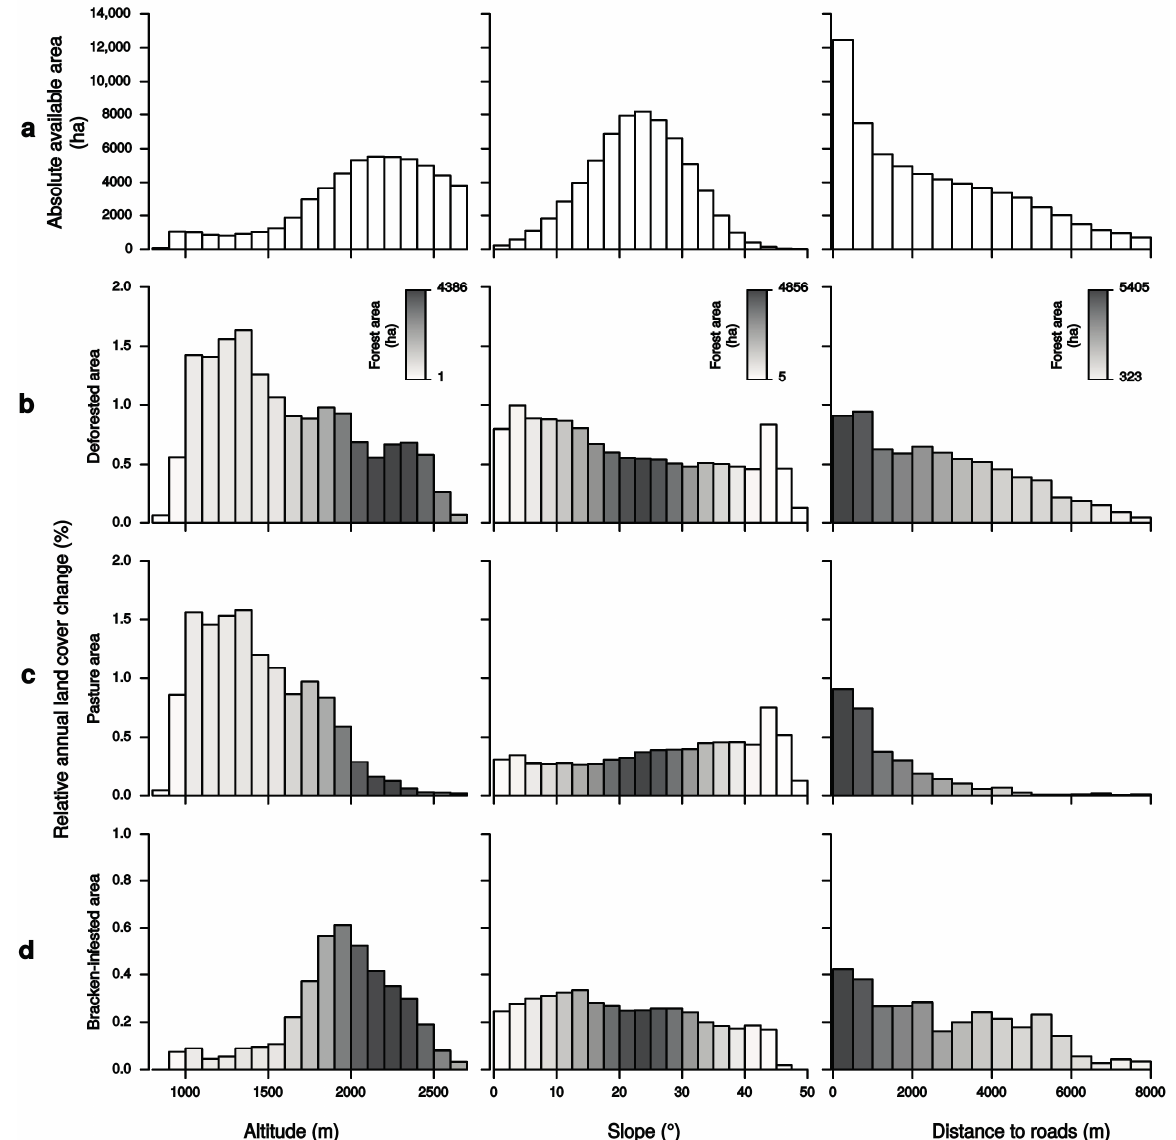
Figure 11. Bar plots of absolute available area ( first row , a ) in relation to altitude ( left column ), slope ( center ), and distance to roads ( right ). The other figures depict the relative annual land cover change between 1987 and 2001 regarding deforested areas ( second row , b ), pasture lands ( third row , c ), and bracken-infested areas ( fourth row , d ) with respect to the same attractors of land cover change. The grey tones of the bars indicate the total available area covered by forest (in